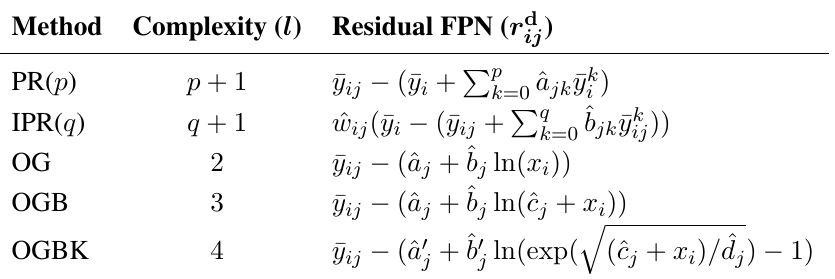
Table 1. Summary of FPN calibration methods. For each method, the complexity is the number of parameters per pixel ( ppp ) required for FPN correction, and the residual FPN is the (weighted) error, at each luminance x and pixel j , of the fitted response. i